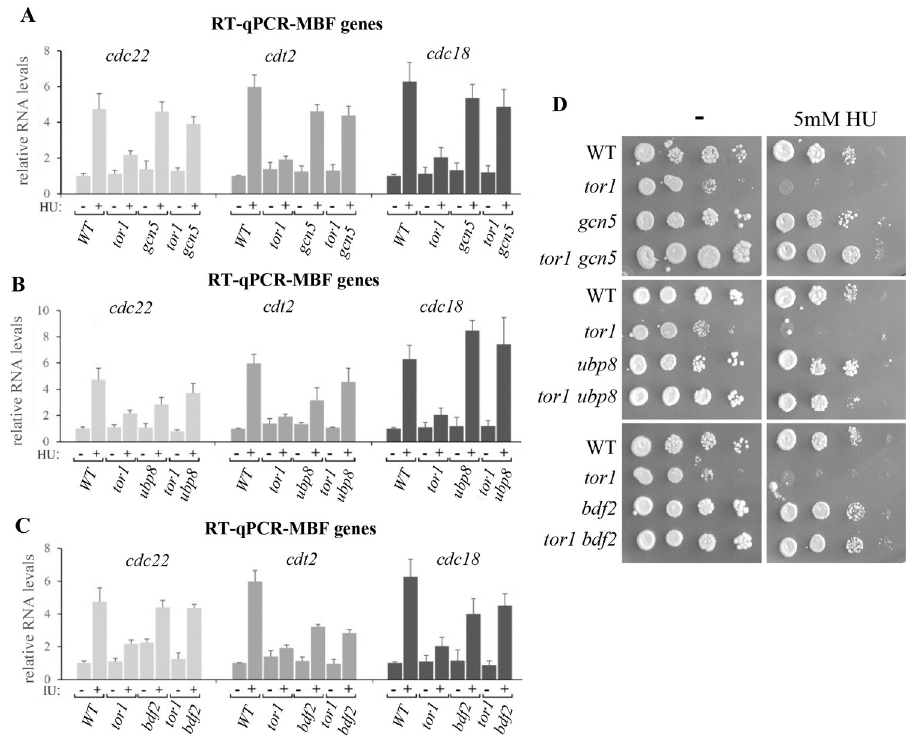
Fig 3. Loss of SAGA or Bdf2 suppress the lack of MBF-regulated gene induction and sensitivity to DNA replication stress in TORC2 mutant cells. ( A-C ) Quantification of transcript levels of cdc22 + , cdt2 + and cdc18 + in wild type (WT) and the indicated deletion mutant cells. Total RNA was prepared from untreated cells (-) or cells treated with 12 mM HU for 3 hours (+). The level of act1 + mRNA was used as a reference. Each value is the mean of at least three independent assays, and the error bars indicate standard deviation. ( D ) Serial dilution of exponentially growing wild type and deletion mutant cells were spotted onto minimal medium, with or without 5 mM hydroxyurea